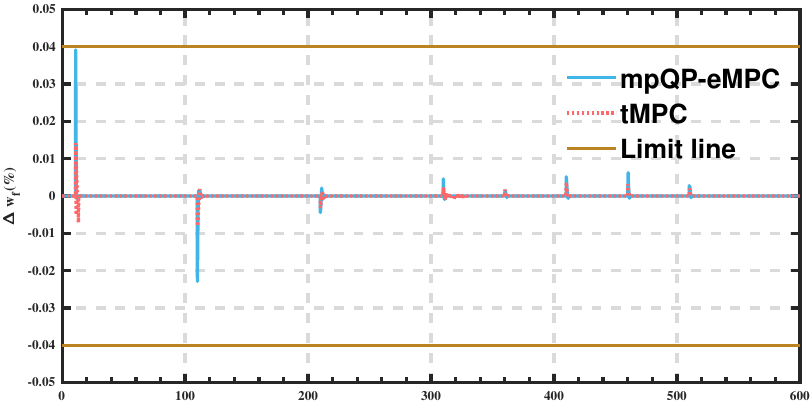
Figure 14. The response curves of fuel w f .